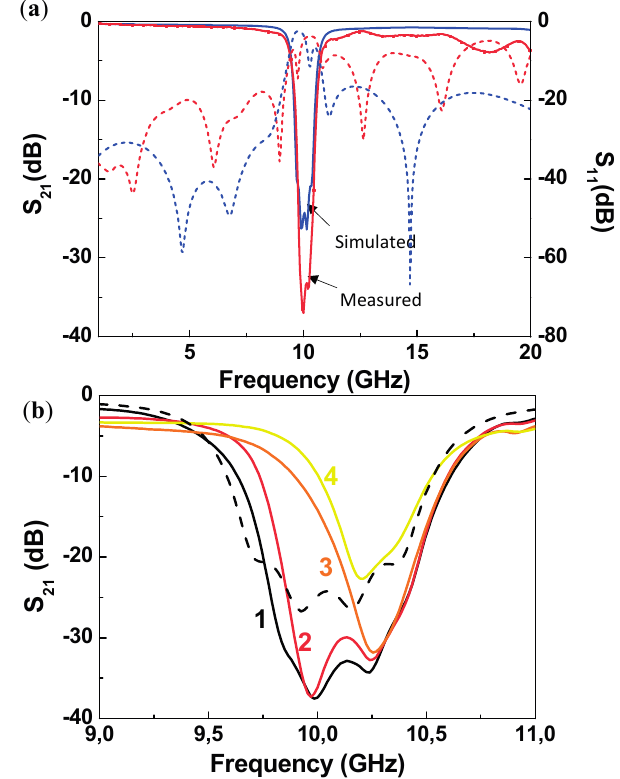
Figure 10. Simulated and measured insertion (solid lines) and return (dashed lines) loss of the 4-pole reconfigurable stopband filter when all switches are at up-state ( a ). Simulated (dashed line) and measured (solid lines) responses of the device for different combinations of switches actuated ( b ). Measurements indicated as 1, 2, 3 and 4 correspond to bits ABCD set to ‘0000’, ‘0001’, ‘0011’ and ‘1011’, respectively, with ‘0’ corresponding to MEMS at up state ( i.e. , non actuated) and ‘1’ corresponding to MEMS at down state. From [21], reprinted with